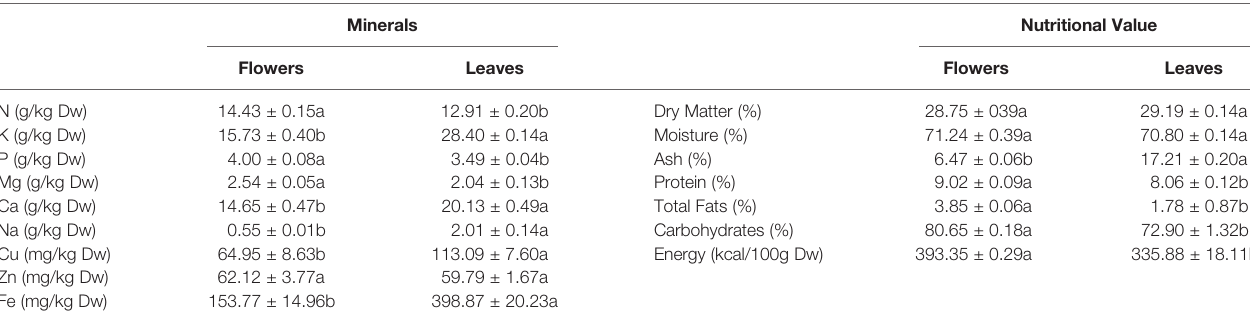
TABLE 1 | Mineral analysis and nutritional value of aerial plant tissue, leaves, and fl owers. Minerals